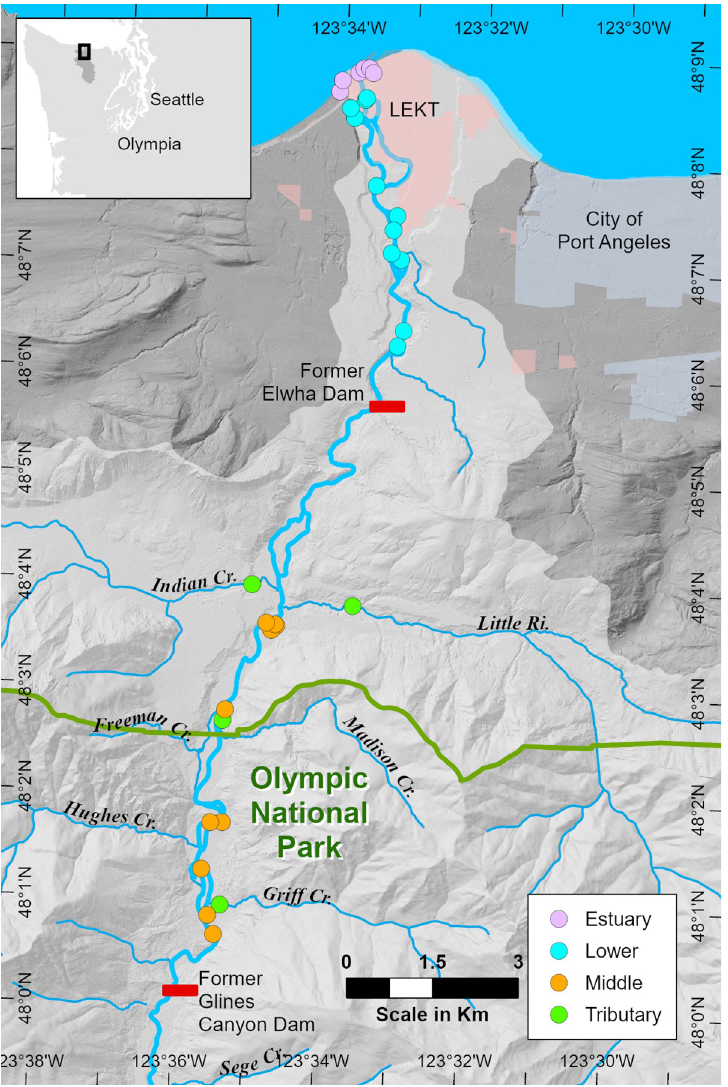
Fig 1. Study region. Distribution of samples sites across three sediment-impacted (Estuary, Lower Elwha, Middle Elwha) and one control (Tributary) section, relative to former dams on the Elwha River on the Olympic Peninsula (inset map) of Washington State, USA. Estuary markers represent sample areas with multiple replicates. Reservation lands of the Lower Elwha Klallam Tribe (LEKT) are shown in pale pink; the horizontal green line indicates the Olympic National Park Boundary. Map scale 1:124,000. Data layers: LiDaR DEM hillshade: USGS, LEKT, NOAA; Washington State DNR: tributaries and drainage basin; City of Port Angeles, NPS, LEKT: political boundaries. Generated by Randall E. McCoy, Lower Elwha Klallam Tribe Department of Natural Resources, on August 19, 2020 using ArcGIS Pro [GIS]. Version 2.5.2. Redlands, CA: ESRI, 2019. File: Elwha River Watershed 19 (fish diet figure).